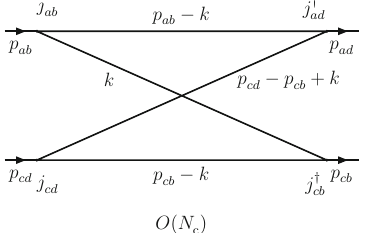
Fig. 18 Recombination diagram of Fig. 2a with explicit momentum flow